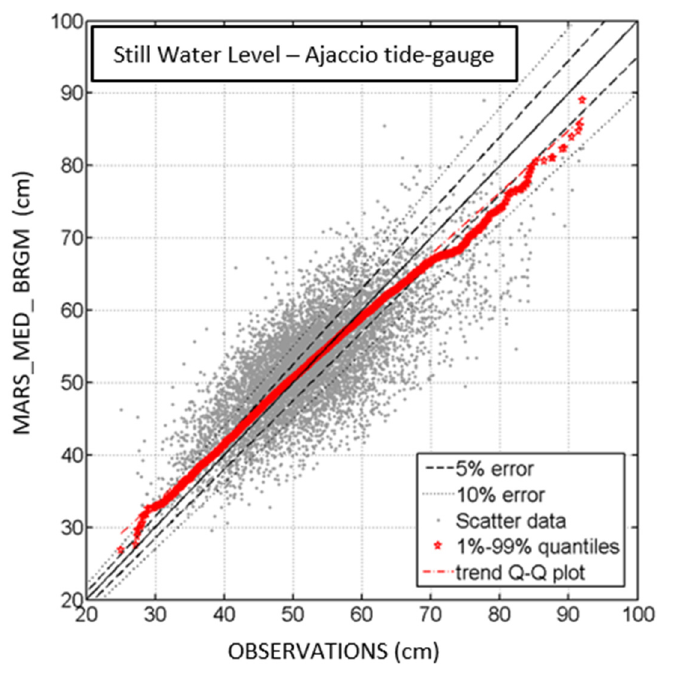
Figure A1. Q–Q plot and scatter plot of hourly still water levels measured at Ajaccio tide gauge (OBSERVATIONS) and values obtained by numerical simulation (MARS_MED_BRGM).